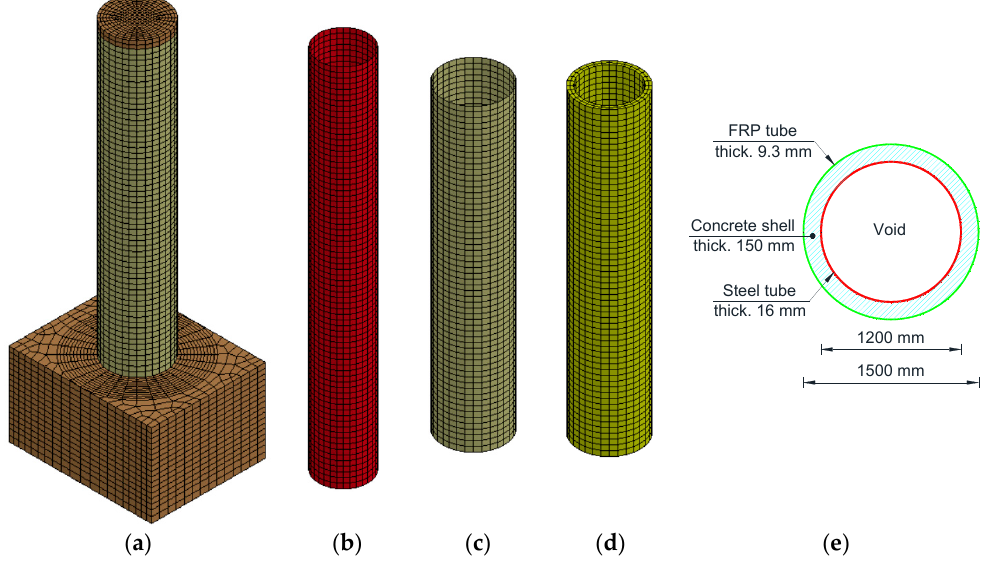
Figure 2. Modeling of the C0-H column: ( a ) overall view of the column; ( b ) steel tube; ( c ) FRP tube; ( d ) concrete shell; and ( e ) cross-section.